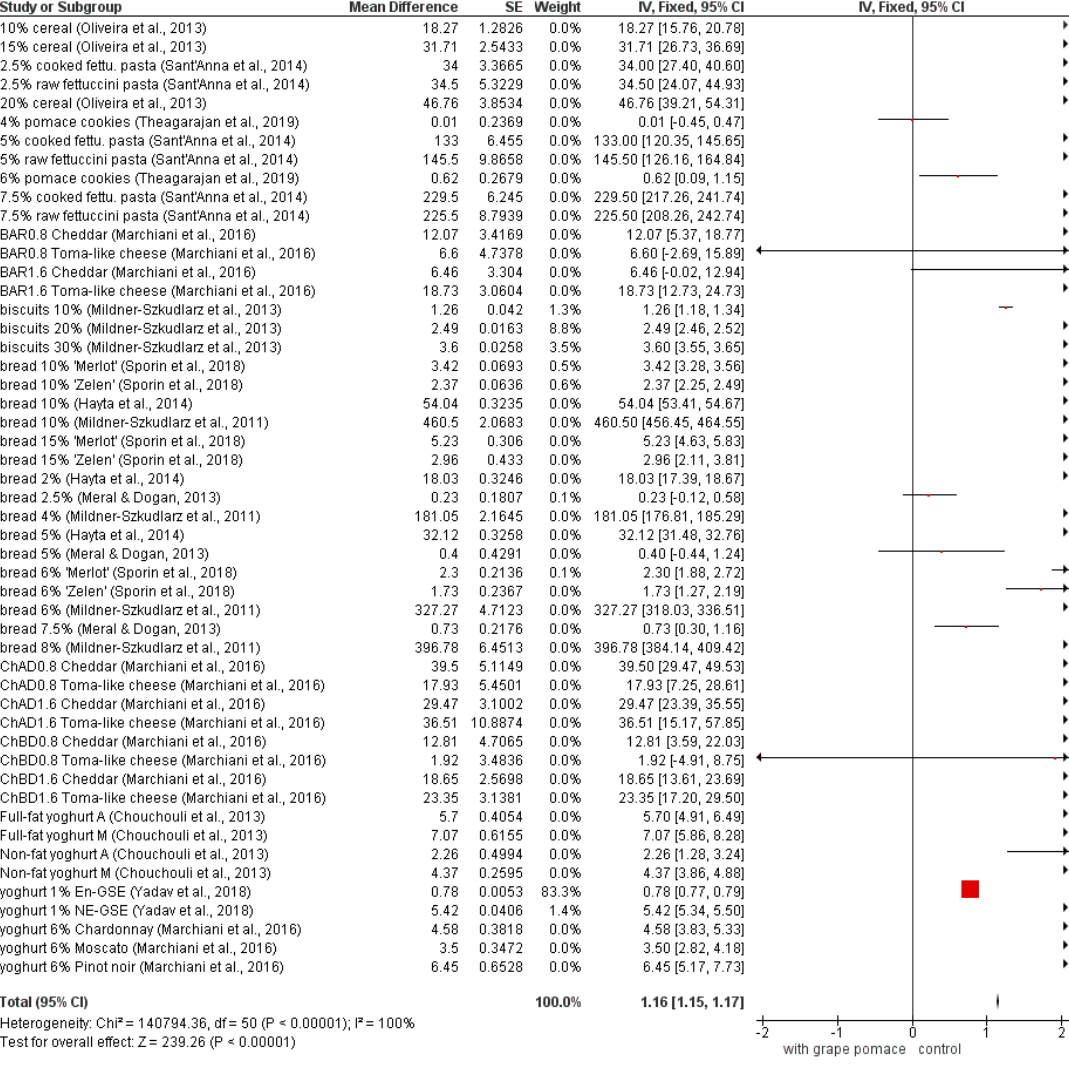
Figure 2. Meta-analysis of TPC in fortified products [20,21,23,45–47,50,53,69,71,73]; BAR—Barbera; ChAD—Chardonnay after distillation; ChBD—Chardonnay before distillation; En-GSE— encapsulated grape seed extract; NE-GSE—nonencapsulated grape seed extract; A—Agiorgitiko seed